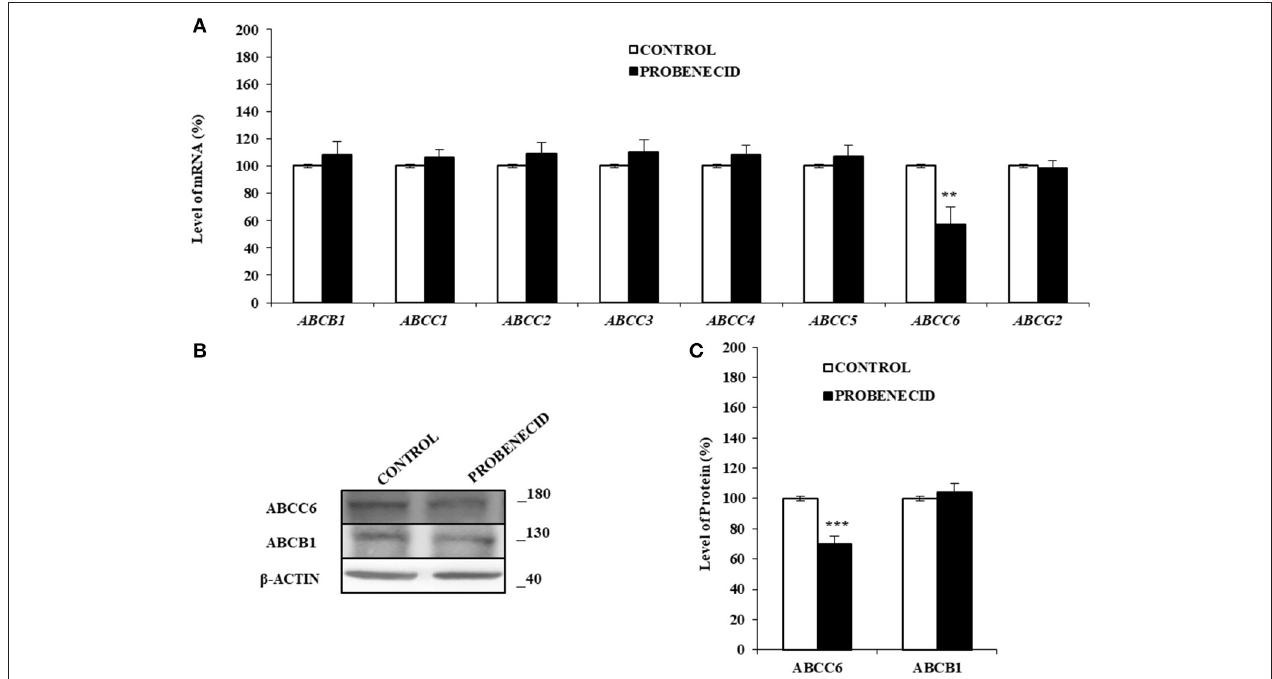
FIGURE 4 | The effects of Probenecid on some ABC genes and ABCC6 and ABCB1 proteins. (A) Fold change in some ABCs mRNA levels compared to the control cells. Results are represented as the mean ± S.D. ( n = 3). ** p < 0.01, Student’s t -test. (B,C) Representative western blot and densitometric analysis of the ABCC6 and ABCB1 in three independent experiments (means ± SD). *** p < 0.001, Student’s t -test. β -actin was used as a loading control. All the experiments were performed treating HepG2 cells with 250 µ M of Probenecid for 48h. DMSO-treated cells were used as control.